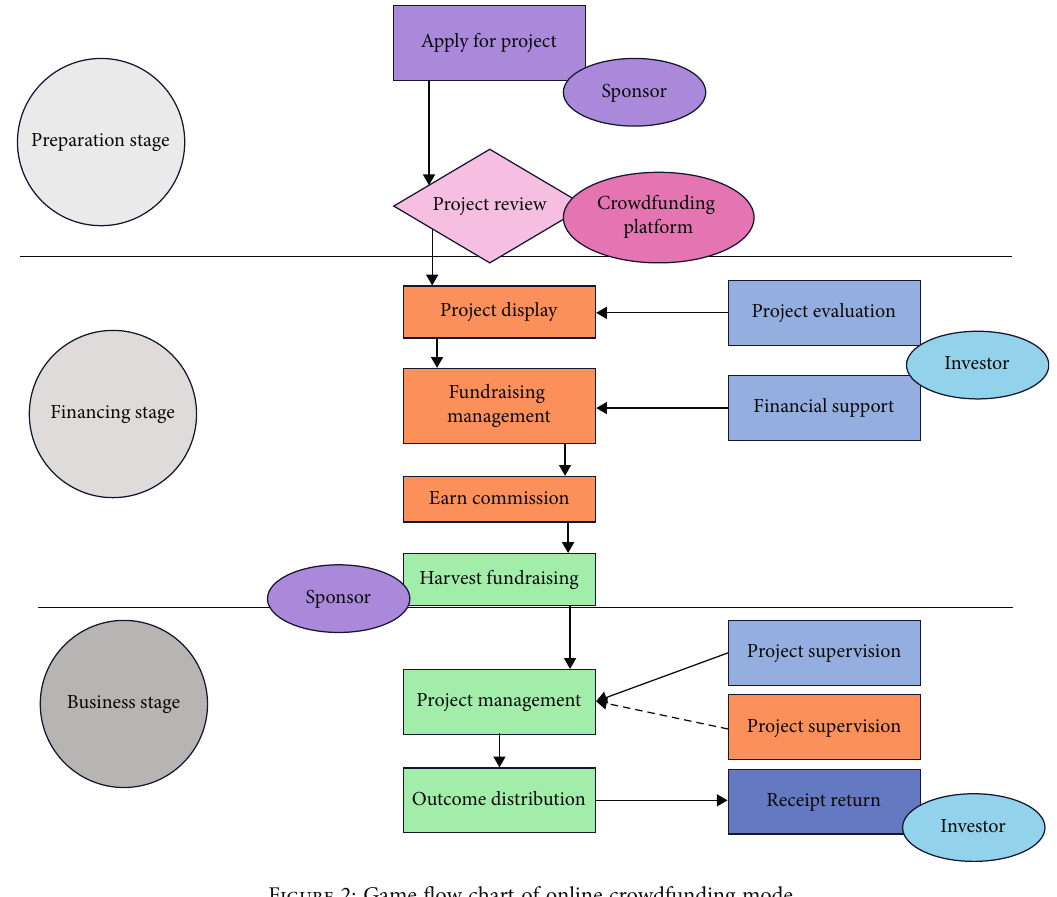
Figure 2: Game fl ow chart of online crowdfunding mode.